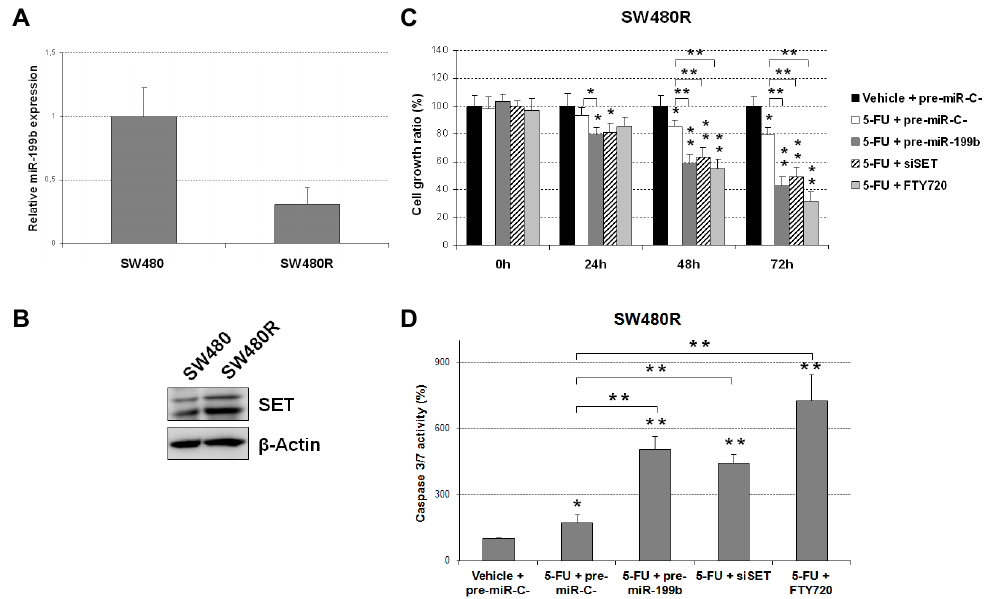
Figure 4. The miR-199b/SET axis is involved in 5-FU resistance. ( A ) Real-time PCR showing relative miR-199b expression in SW480 and SW480R cells; ( B ) Western blot analysis of SET expression in SW480 and SW480R cells; ( C ) MTS assay and ( D ) caspase 3/7 assay showing effects of miR-199b overexpression or SET inhibition in SW480R cells treated with 5-FU (1 µM); * p < 0.05; ** p < 0.01. Detailed information about western blot can be found in Figure S2.